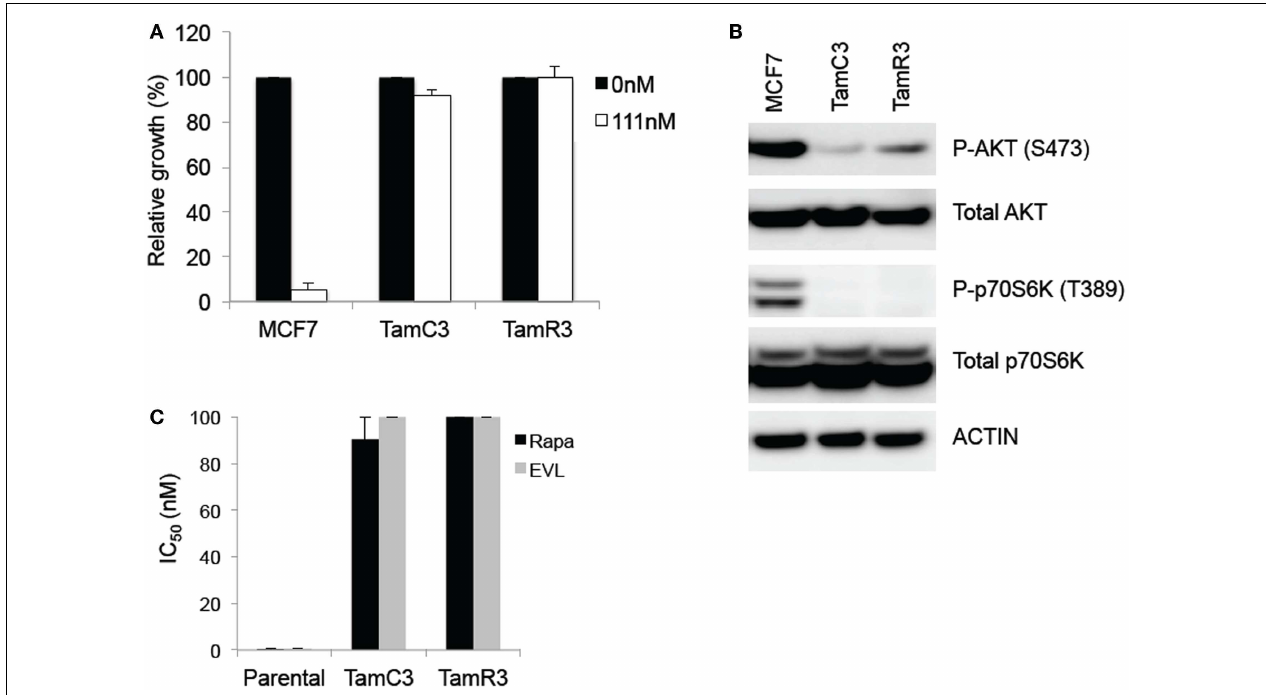
(B) Relative expression of phosphorylated p70S6K and Akt, and total p70S6K and Akt in MCF-7,TamC3, andTamR3 cell lines. Actin is shown as a loading control. (C) IC 50 values for rapamycin and everolimus in MCF-7 parental, TamC3, andTamR3. Cells were treated with rapamycin or everolimus for 4days with [ 3 H]-thymidine added for the last 6h.The highest drug concentration is depicted where 50% growth inhibition was not reached. Bars indicate SE (duplicate